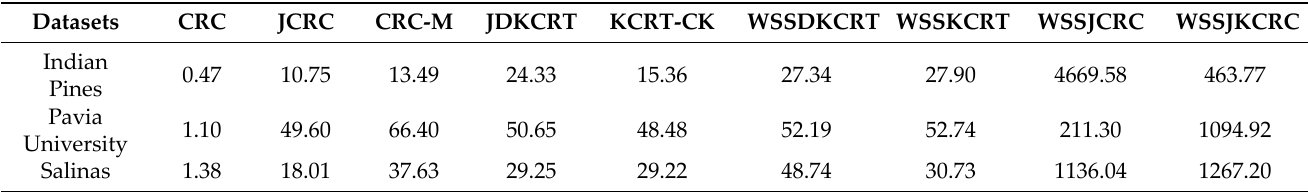
Table 8. Running time (seconds) of different methods for land cover